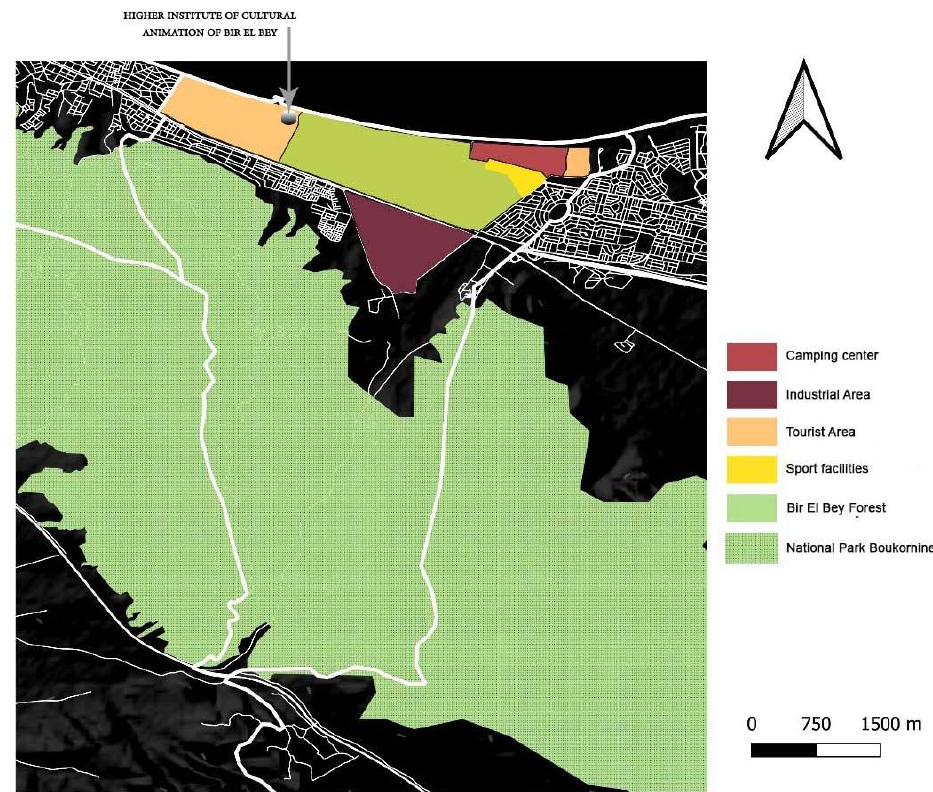
Figure 3. Land use map of Hammam Chott .